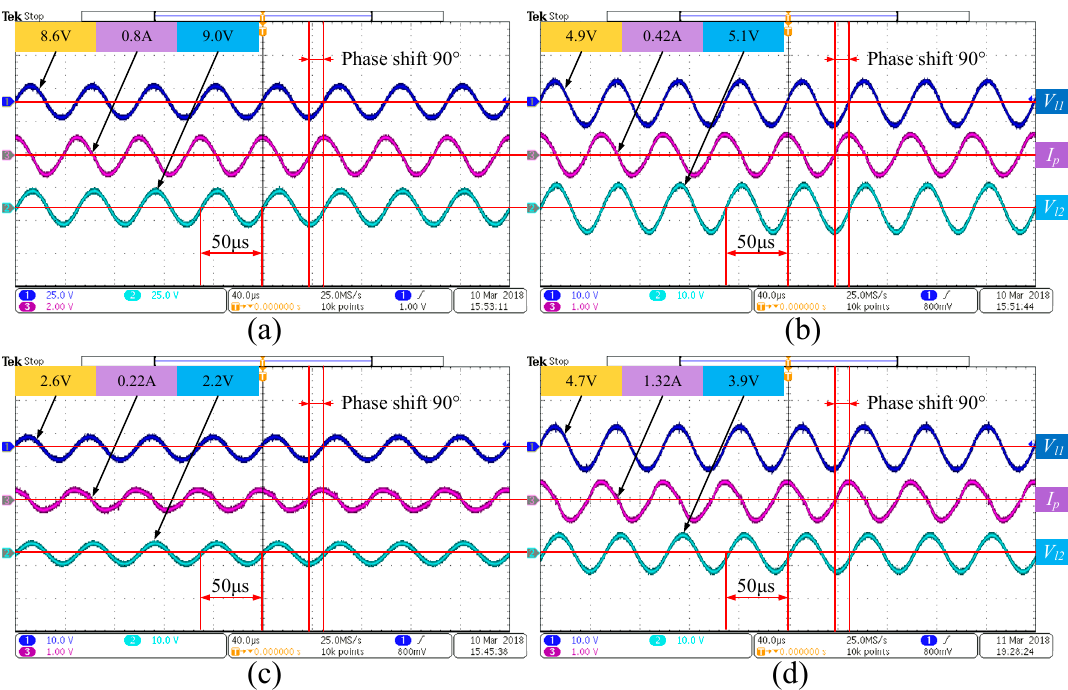
Figure 12. Measured waveforms with Ch1: Load 1 voltage (25 V/div in ( a ) and 10 V/div in ( b – d ), Ch2: Load 2 voltage (25 V/div in ( a ) and 10 V/div in ( b – d ), Ch3: primary circuit current (2 A/div in ( a ) and 1 A/div in ( b – d ), (40 μ s/div): ( a ) R l 1 = 15 Ω , R l 2 = 15 Ω and C p = 0 nF; ( b ) R l 1 = 15 Ω , R l 2 = 15 Ω and C p = 47 nF; ( c ) R l 1 = 5 Ω , R l 2 = 5 Ω and C p = 47 nF; ( d ) R l 1 = 10 Ω , R l 2 = 5 Ω and C p = 16.8 nF.